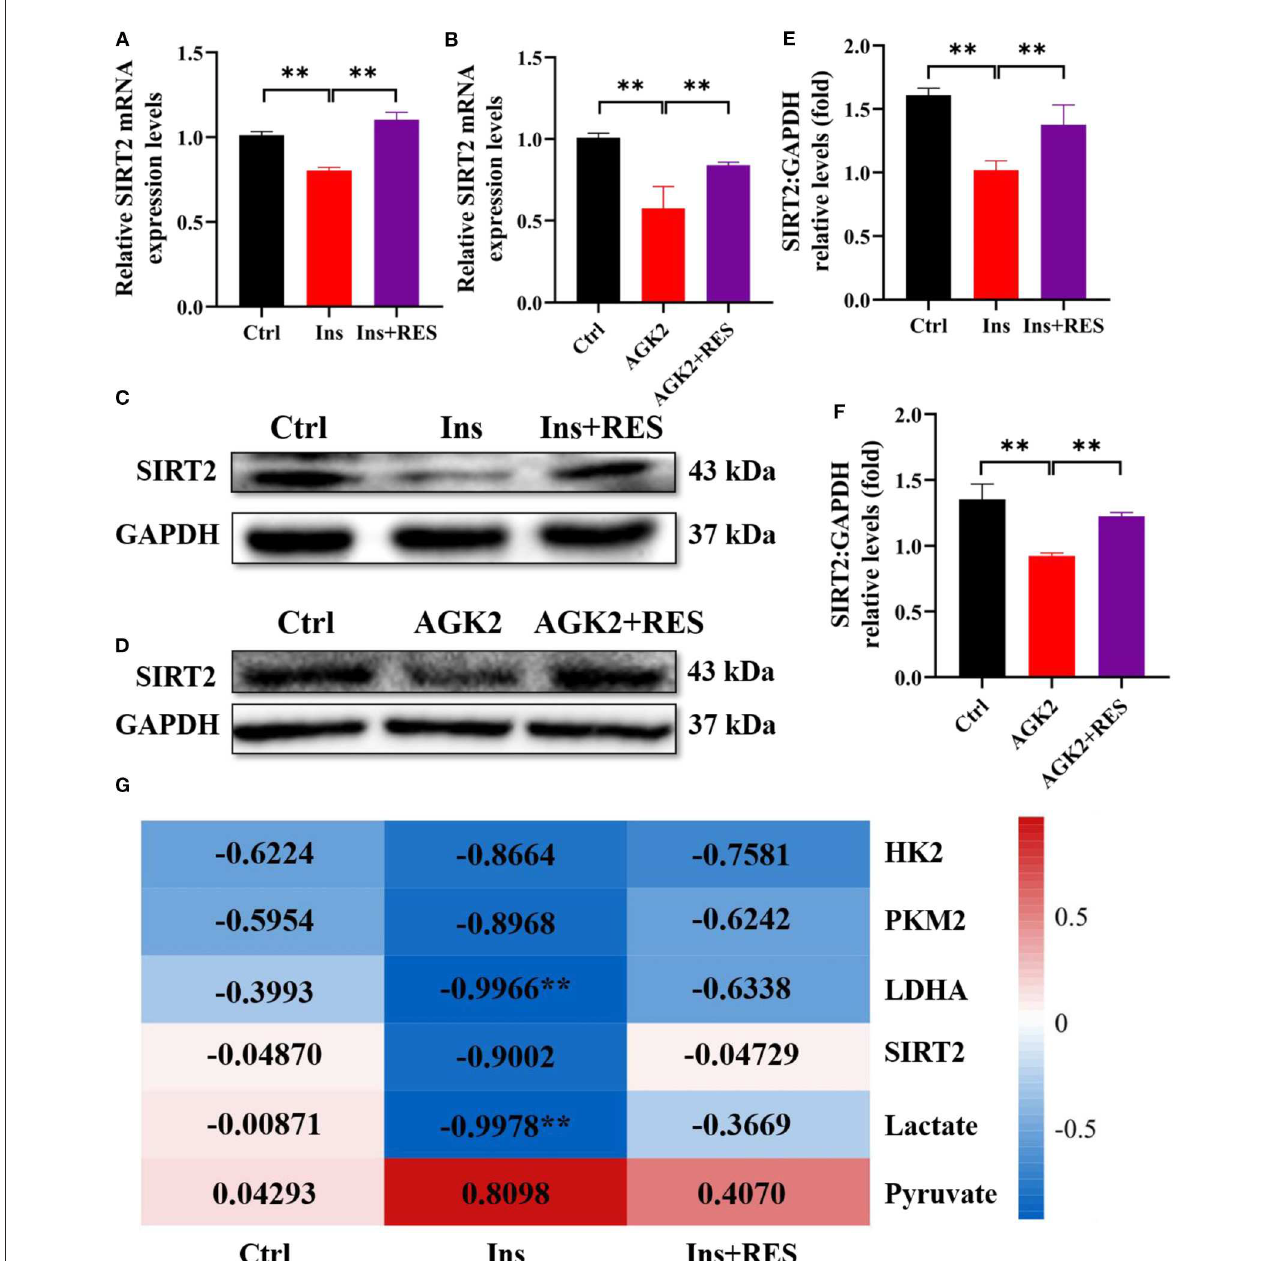
FIGURE4 RES can upregulate the expression of SIRT2 in KGN cells treated with insulin and AGK2. The relative mRNA expression levels of SIRT2 (A, B) in KGN cells were determined using qPCR. The protein level of SIRT2 was determined by Western blot (C, D) and quantified by ImageJ software (E, F) . Correlation analysis between insulin sensitivity and glycolysis (G) . Significant differences between groups are shown as ** P < 0.01.